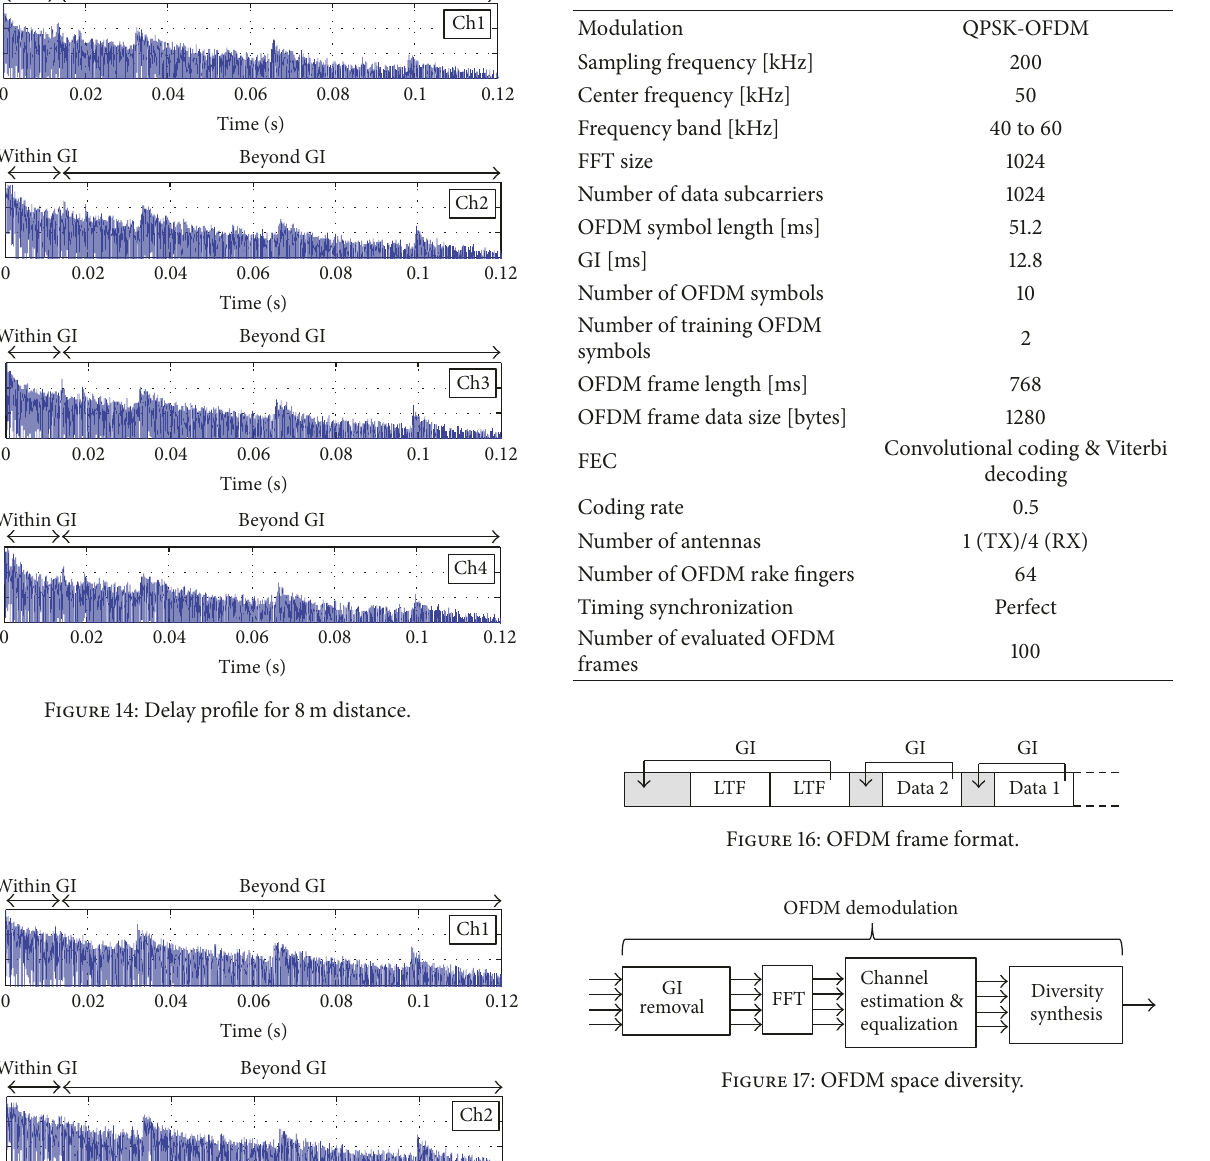
Table 2: Simulation parameters.